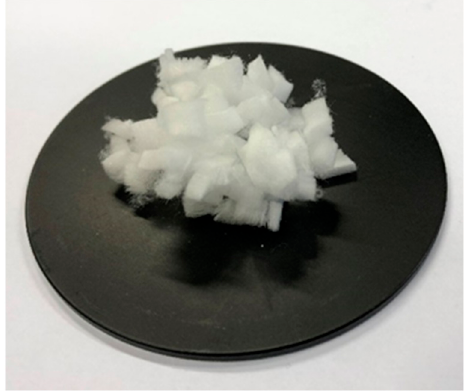
Figure 1. Melamine